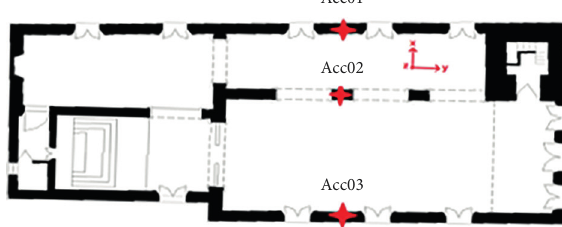
Fig. 9. Accelerometers positioning and data collecting